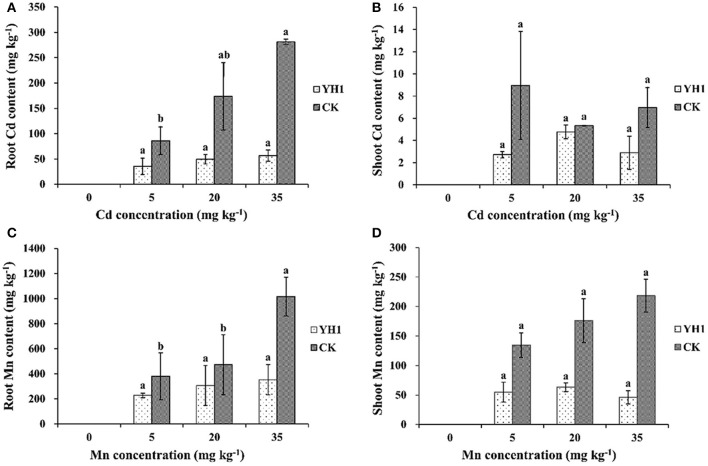
Cd contents in (A) shoot and (B) root, Mn contents in (C) root and (D) shoot of L. leucocephala after 6 months growth in vermiculite supplemented with three different concentrations of Cd or Mn. YH1, plants inoculated with strain YH1; CK, control group without inoculation. Different lowercase letters following data in either the YH1-inoculated or the YH1-free control group treated with different concentrations of the same metal show the statistical difference is significant at P < 0.05 according to LSD test. Error bars represent standard deviations.